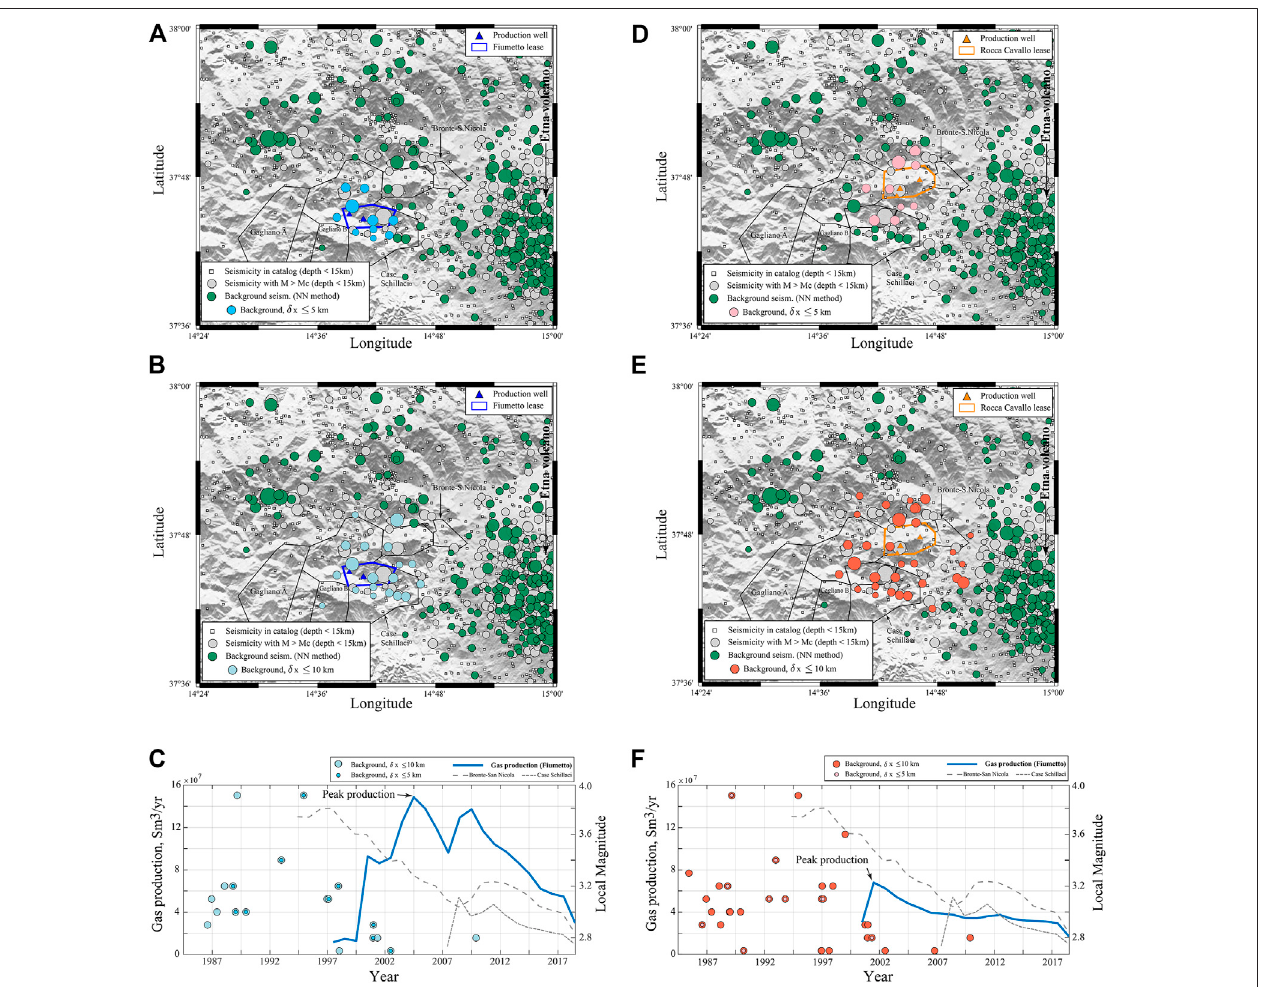
FIGURE 10 | Seismic and production data used in the analysis for Fiumetto (A,B,C) and Rocca Cavallo (D,E,F) leases. For the event locations: squares represent the full catalog, whereas the circles show all the events above M c ; colored circles show events identi fi ed as background seismicity. Top: map showing background seismicity, highlighting all the events located at distances δ x (cid:1) 5 from the production wells. Middle: the same as the top, but highlighting events at δ x (cid:1) 10 km. Bottom: Time series of production data and plot of the temporal occurrence and magnitude of seismic events. Production data and location of the nearby Bronte-S. Nicola and Case Schillaci leases are also shown for